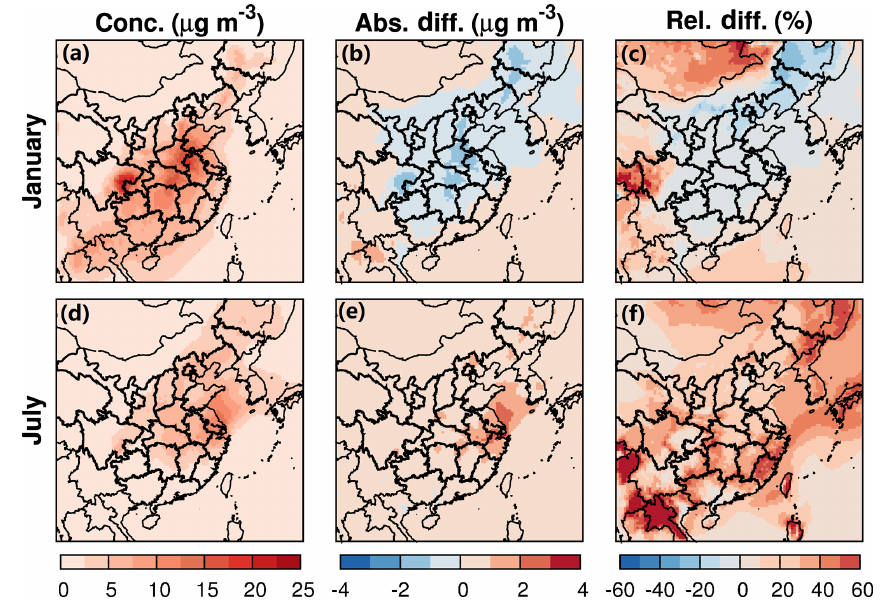
Figure 2. Monthly averaged SOA from C3 and changes in SOA due to water partitioning into OPM and nonideality of the organic–water mixture. “Abs. Diff.” represents absolute differences (C3–BC); “Rel. Diff.” represents relative differences ((C3–BC)/BC; %).